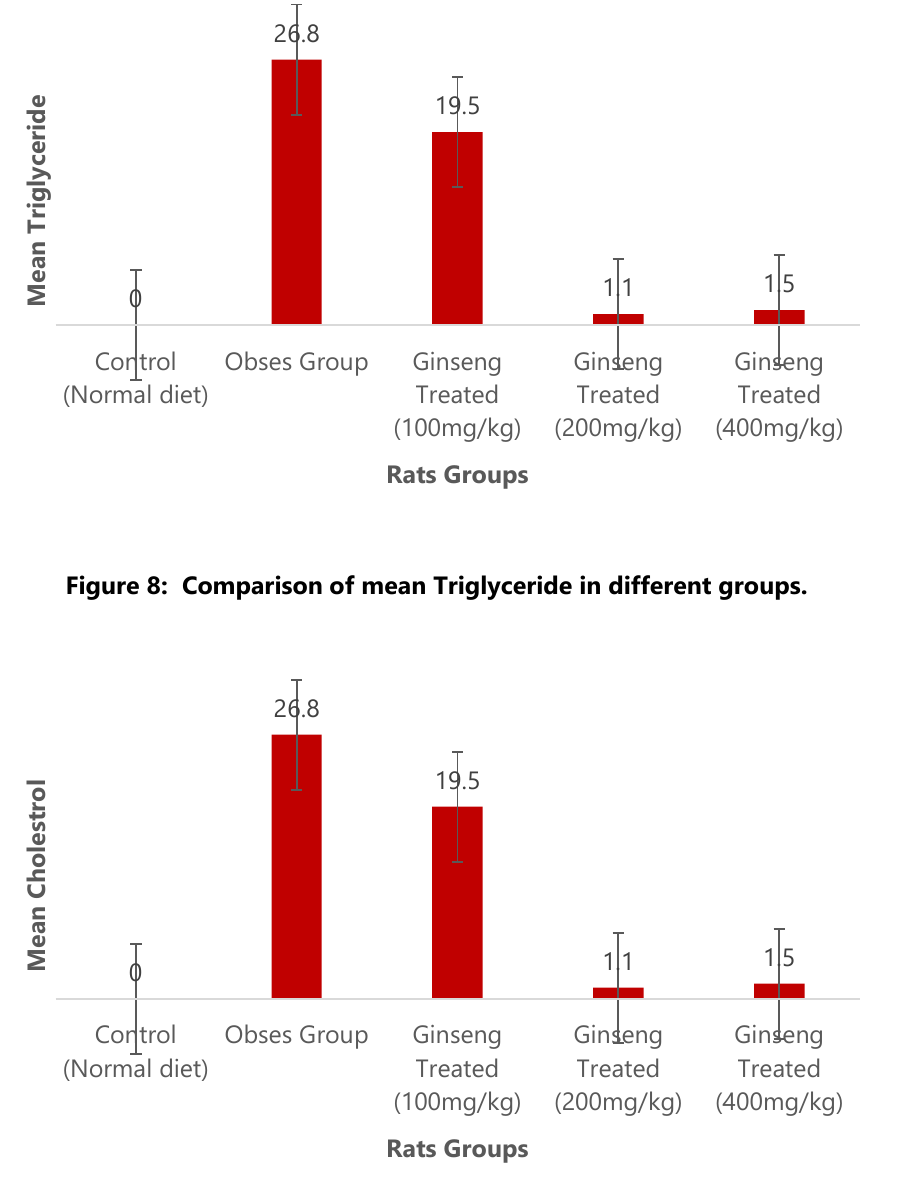
Figure 9: Comparison of mean Cholesterol in different